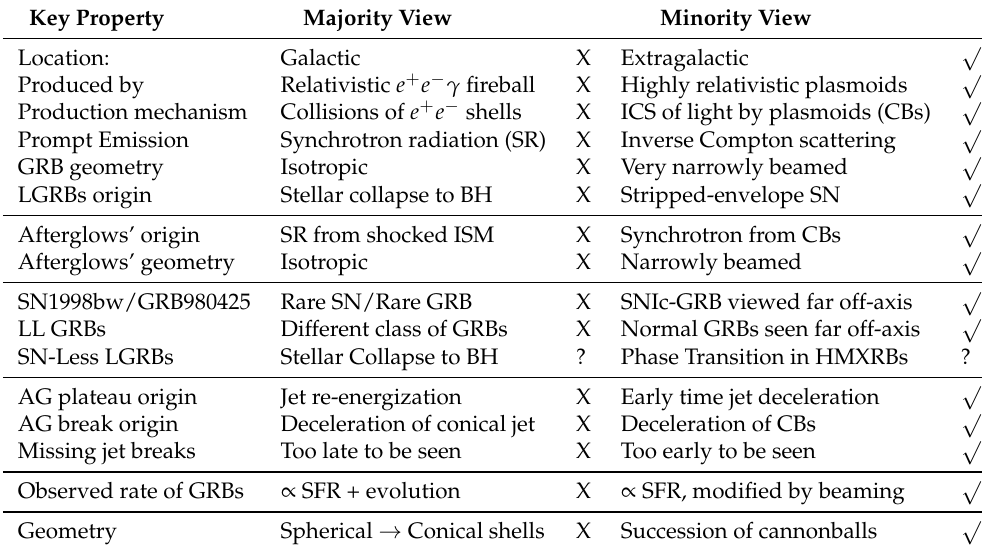
Table 4. Majority and minority views on GRBs preceding decisive